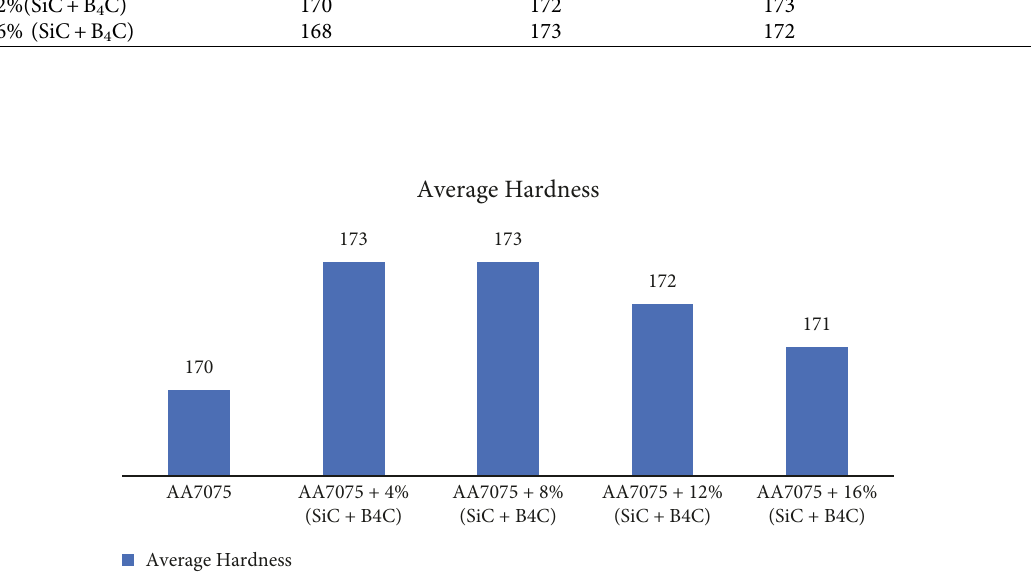
Figure 7: Hardness of unreinforced alloy and hybridized composites.